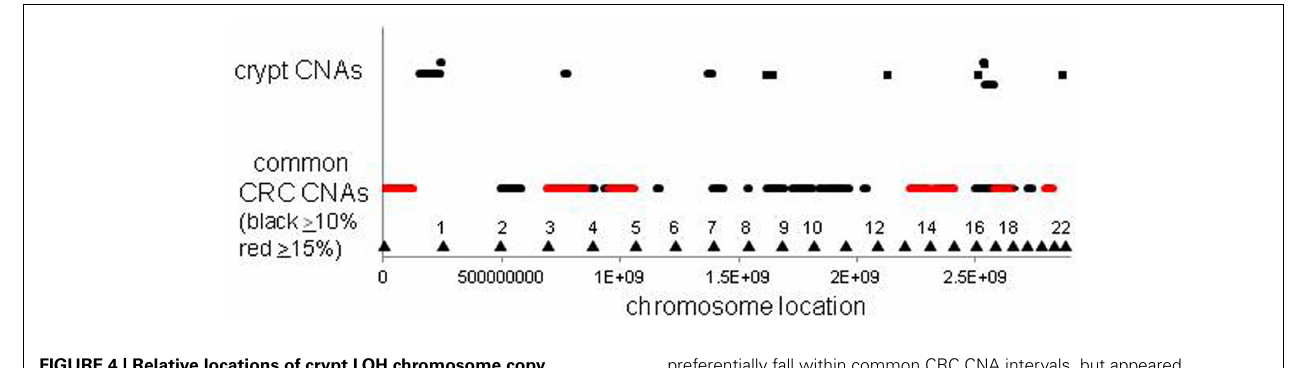
FIGURE 4 | Relative locations of crypt LOH chromosome copy number alterations and common CRC LOH copy number alterations [from Ref. (26) ] .The locations of the crypt CNAs did not